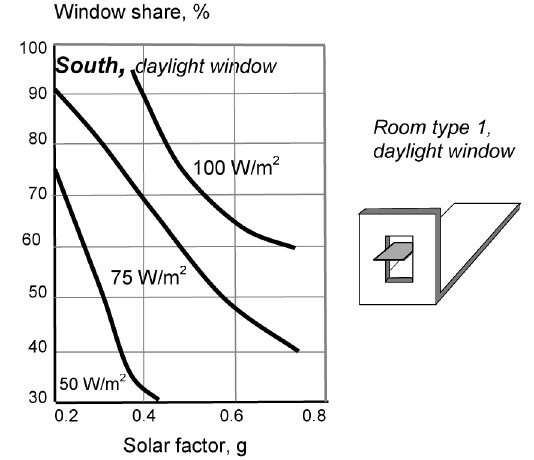
Fig. 12. Possible combinations of window glass share and solar factor for room type 1 with a daylight window for maximum cooling power demand of 50, 75, or 100 W/m